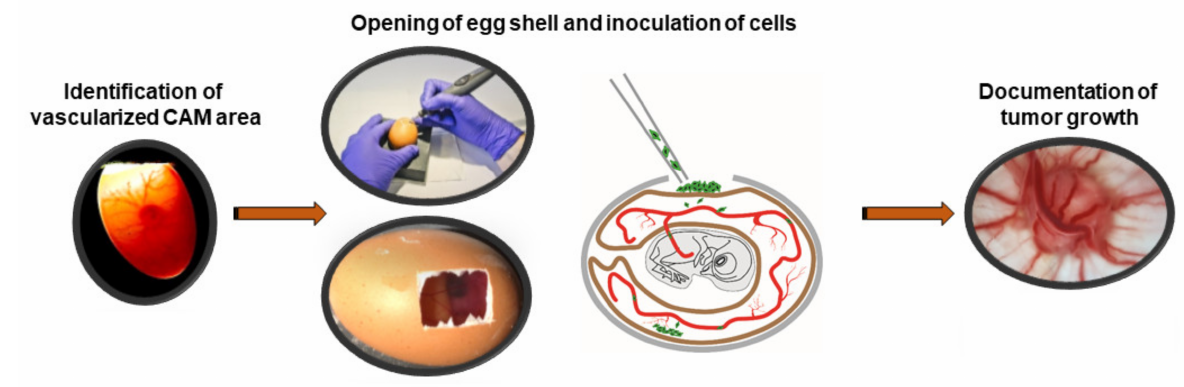
Figure 4. In ovo CAM model for tumor growth after inoculation of RB tumor cells.